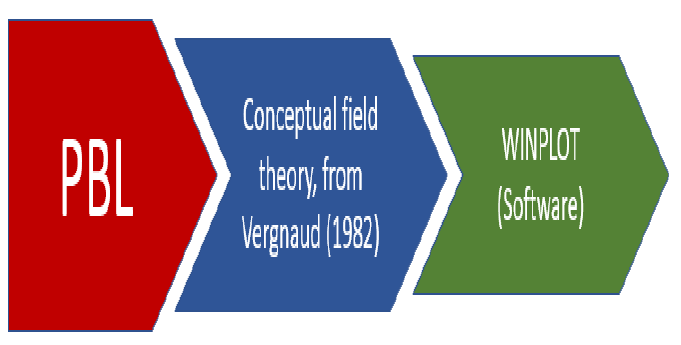
Fig. 1. Methodology for research on ODEs. Source: